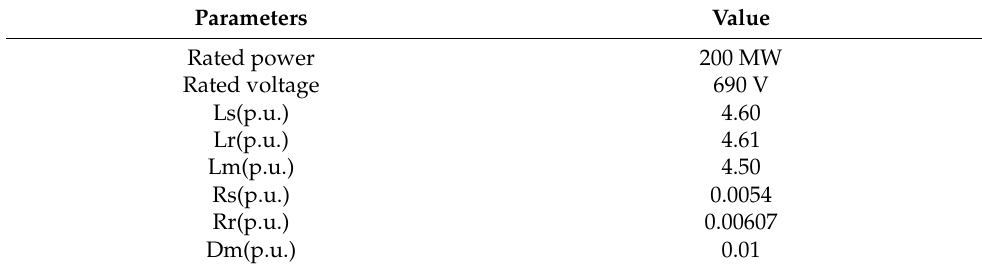
Table A1. Parameters of the DFIG wind farm.